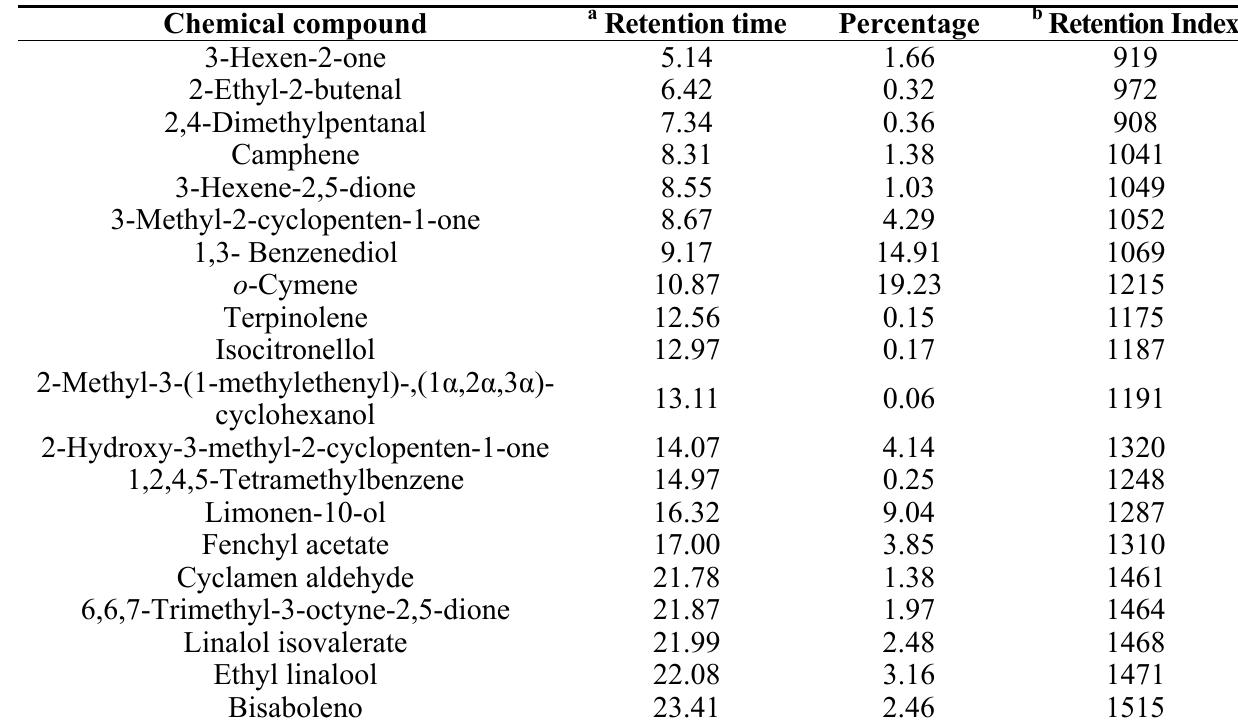
Table 2. Chemical composition of F. vulgare (fraction